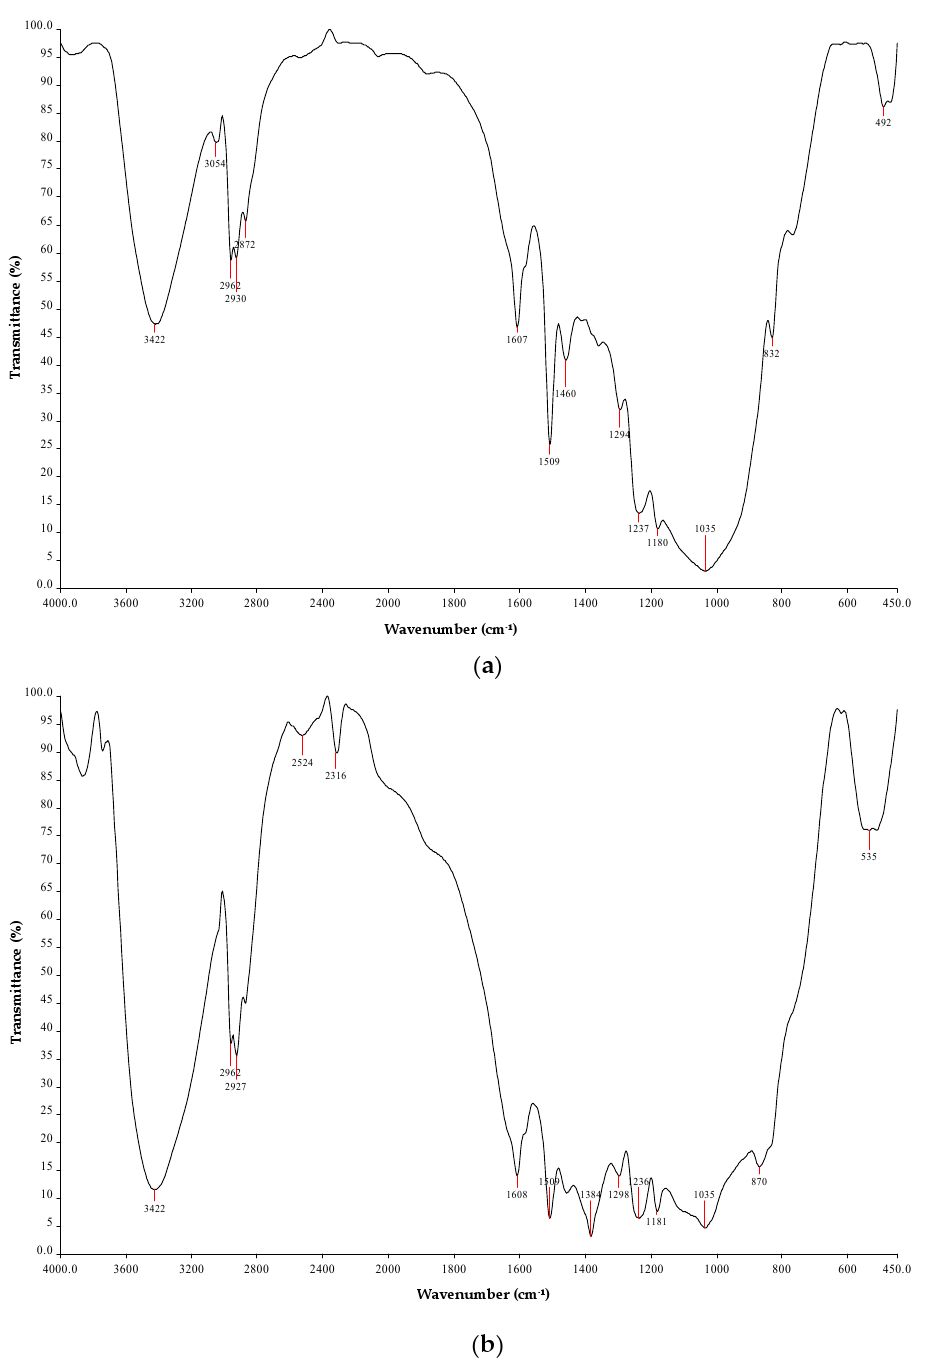
Figure 3. ( a ) FTIR spectrum of pristine epoxy resin ; ( b ) FTIR spectrum of 0.75 wt% nanosilica-loaded epoxy resin .